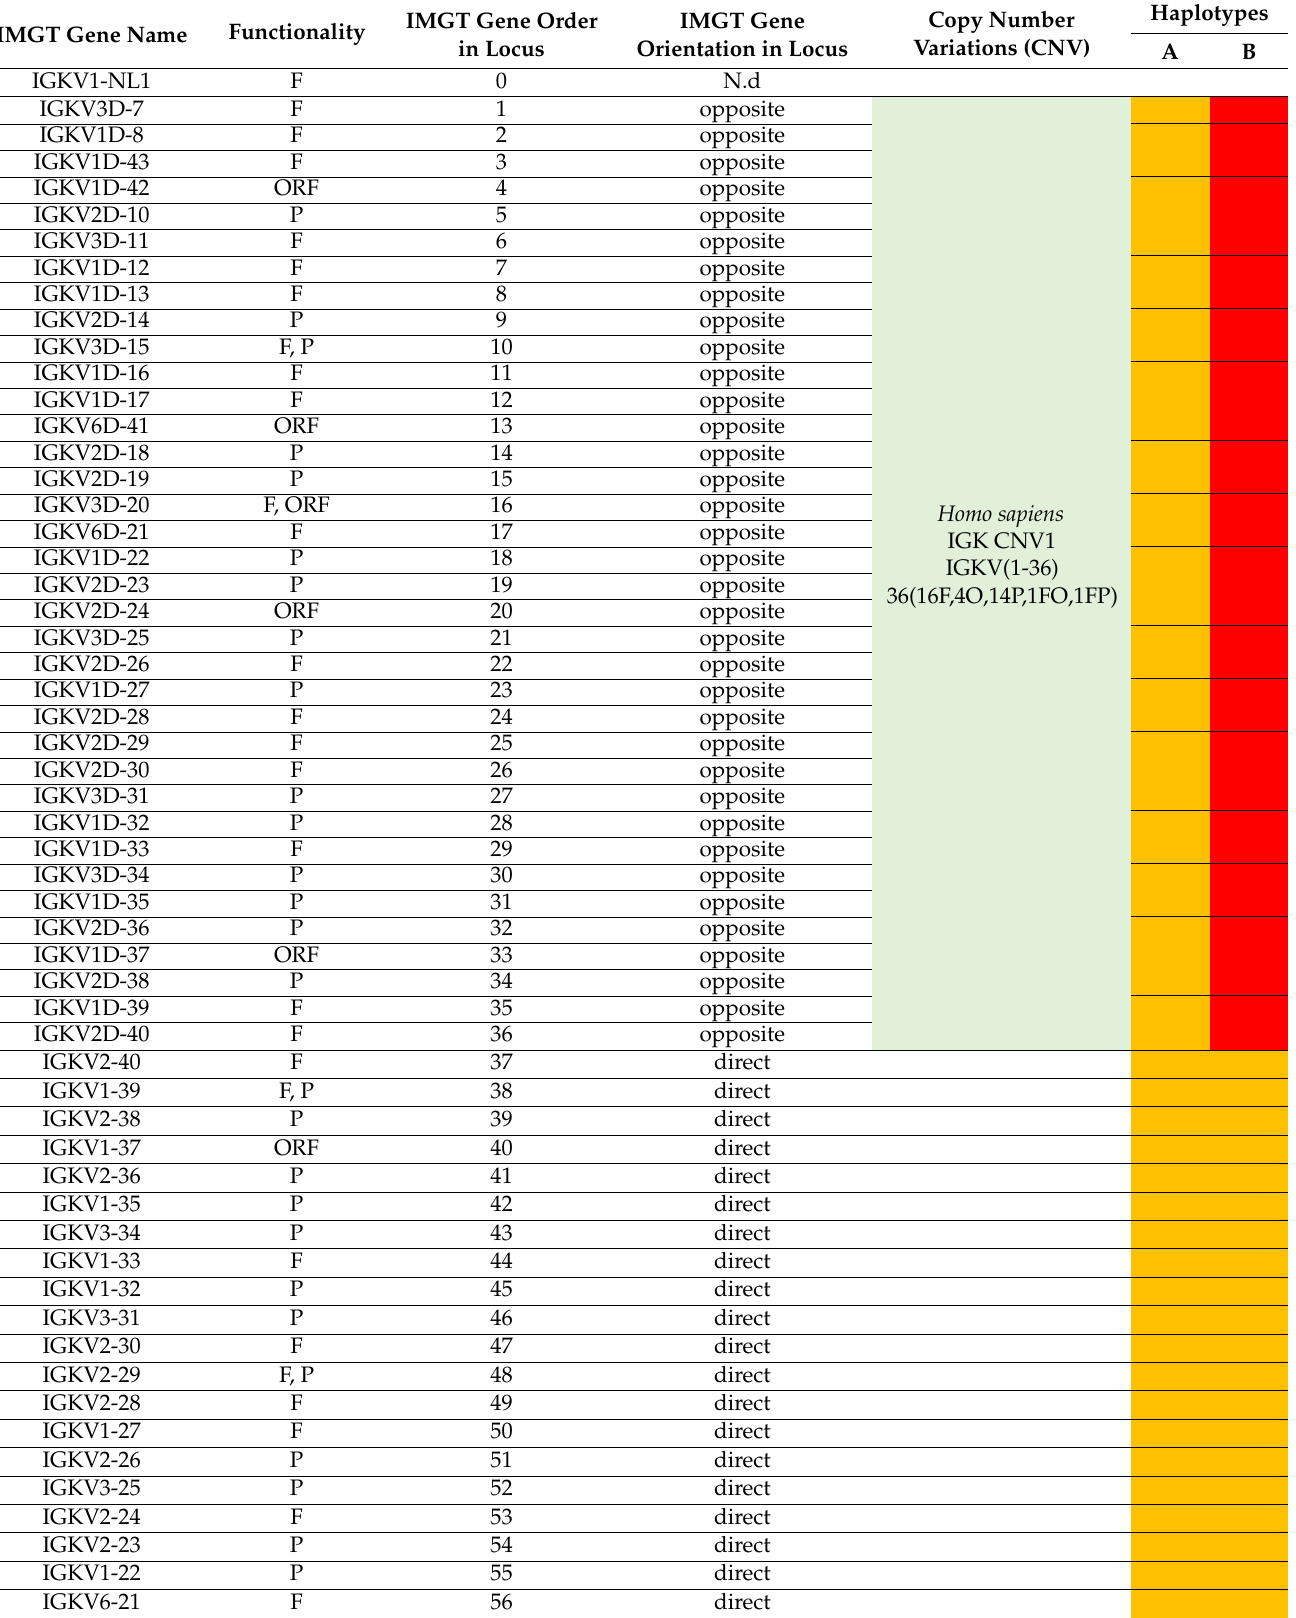
Table 5. Homo sapiens IGK locus: IMGT gene order, copy number variations (CNV) and